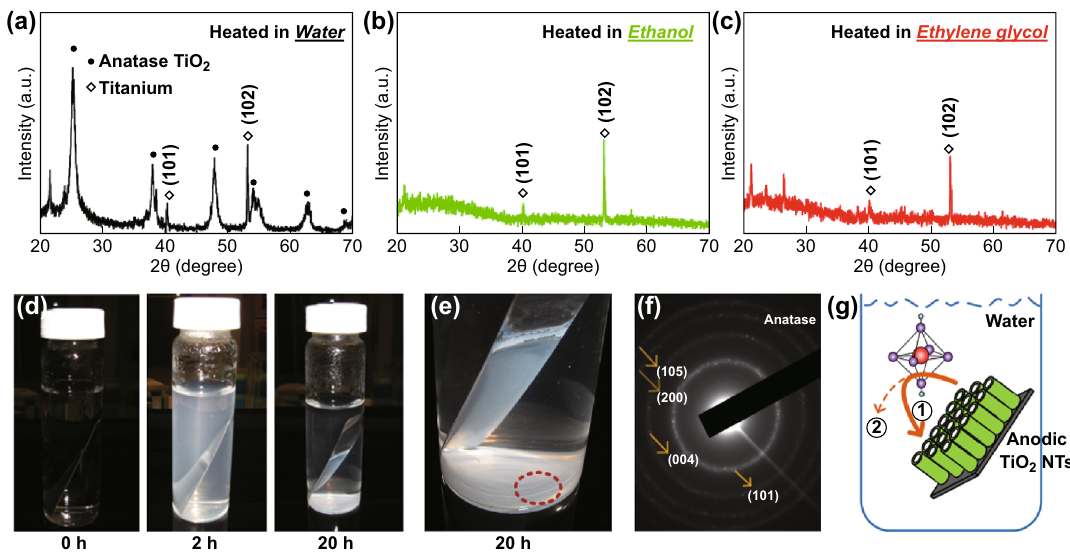
Fig. 4 XRD patterns of anodic TiO 2 NT array films crystallized in a water, b ethanol, and c ethylene glycol at 90 (cid:3) C for 20 h. d Digital photographs of the treatment system at 90 (cid:3) C with treatment duration rising from 0 to 20 h. e Magnified digital photograph of the 20-h sample. f Selected area diffraction pattern of the precipitated TiO 2 nanoparticles, indicating the anatase phase of the precipitated nanoparticles [52]. g Schematic diagram of the dissolution-recrystallization-precipitation mechanism. Copyright (cid:2) 2016 American Chemical Society